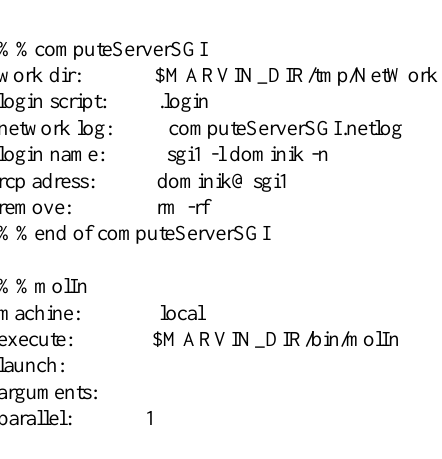
table for Sybyl atom types: $MARVIN_DIR/tables/molIn/AtomTypesSybyl.table table for Sybyl bond types: $MARVIN_DIR/tables/molIn/BondTypesSybyl.table molecular dataset